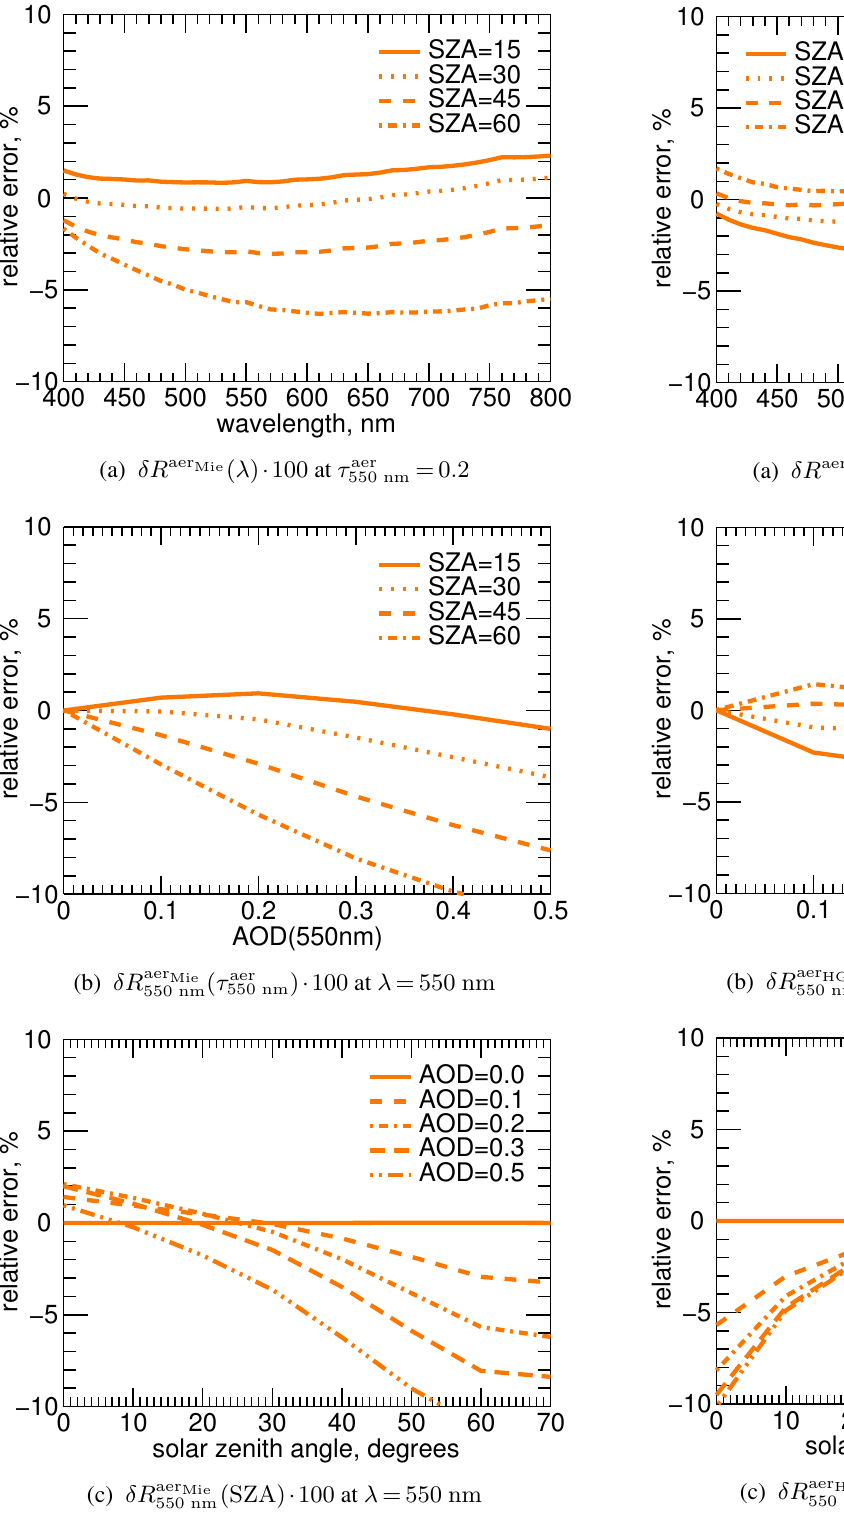
Fig. 4: Percent error of the SMART reflectance function due Fig. 4. Percent error of the SMART reflectance function due to aerosol scattering with respect to wavelength, aerosol op- tical depth (AOD) and solar zenith angle (SZA) at top-of- atmosphere. SMART uses the HG phase function, 6S the phase function from Lorenz-Mie theory.